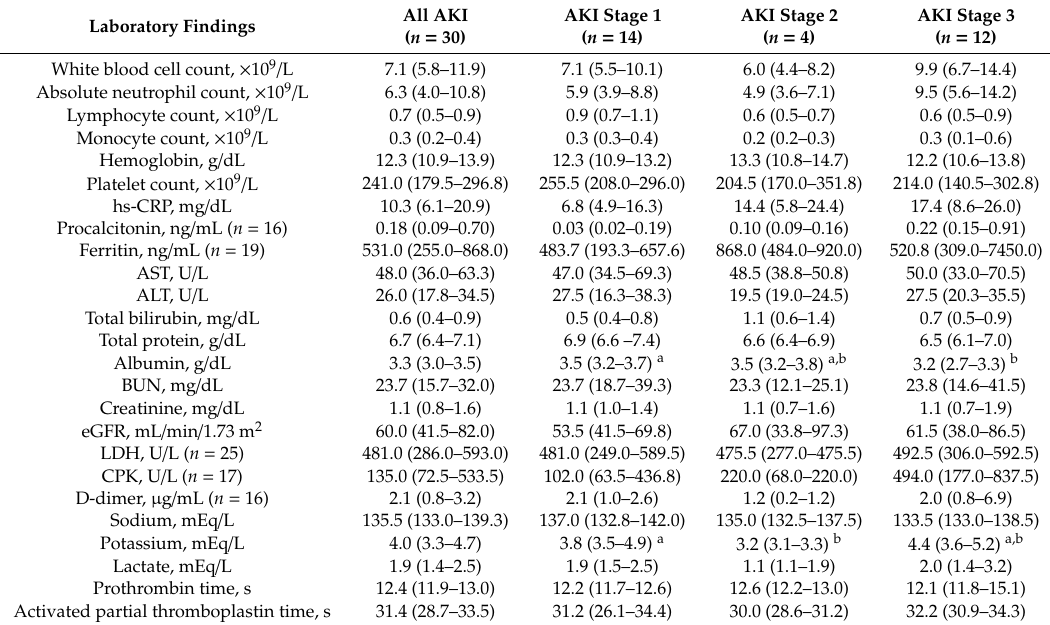
Table 2. Laboratory findings on admission in AKI